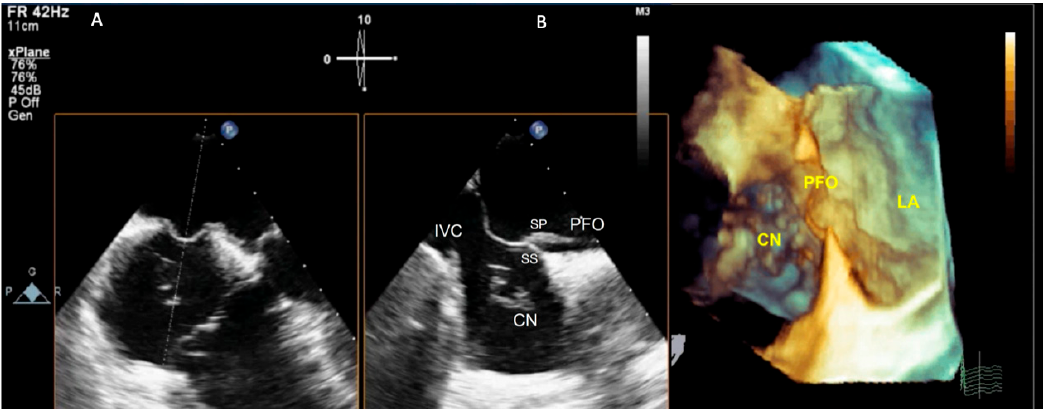
Figure 1. ( A ) Mid-esophageal four-chamber view at 0 degrees and mid-esophageal bi-caval view at 90 degrees, simultaneously obtained by 2D-TEE X-plane modality. Simultaneous biplane mode (X-plane) allows us to obtain two simultaneous 2D images. ( B ) Cropped 3D-TEE image with zoom 3D modality. A complex tunnel PFO is shown. The 3D-TEE image shows a long septum primum (SP), widely separated from the septum secundum (SS). The Chiari network (CN) in the right atrium is displayed. IVC: inferior vena cava; SP: septum primum; PFO: patent formen ovale; SS: septum secundum; CN: Chiari network; LA: left atrium.